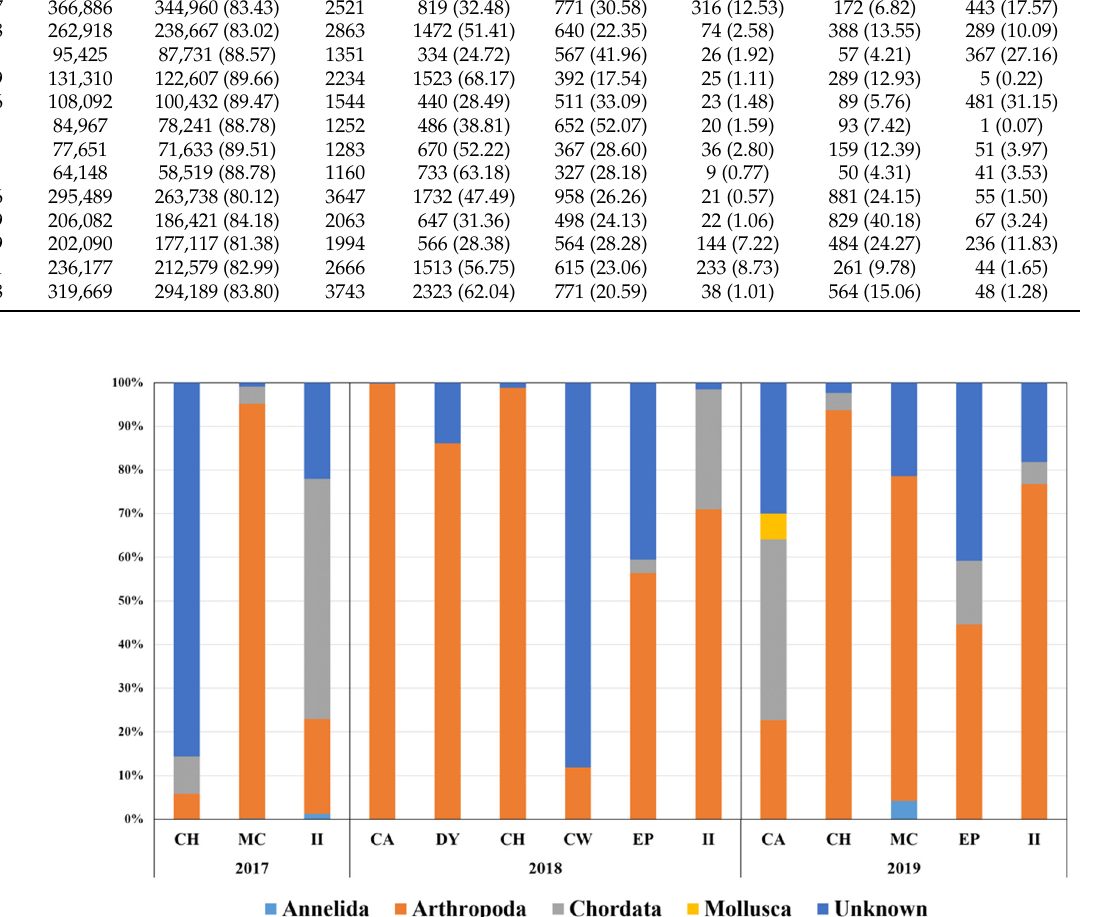
Figure 2. Metabarcoding of fecal DNA using 18Sv9 universal primer set. Graph displays proportions of phyla of prey items at different sites by year. The arthropod OTUs belonged to either E. superba or E. crystallorophias , the average proportion of which among arthropod OTUs was 75.64%. E. crystallorophias (49.88%) was approximately two-fold higher than E . superba (25.14%; Figure 2). The copepod OTUs placed second, with an average proportion in arthropod OTUs of 16.92%. Among seven copepod genera, Calanus (7.78%) was the most abundant, followed by Metridia (4.60%) and Paraeuchaeta (1.90%) (Figure 2). All OTUs in the phylum Chordata showed the highest identity to notothenioid fish, which is the most abundant fish taxon in the Southern Sea. Only two OTUs in Annelida have identified either Lumbrineris sp. or Tomopteris sp., whose average proportion was only 0.40% among the five taxa. One OTU in Mollusca showed